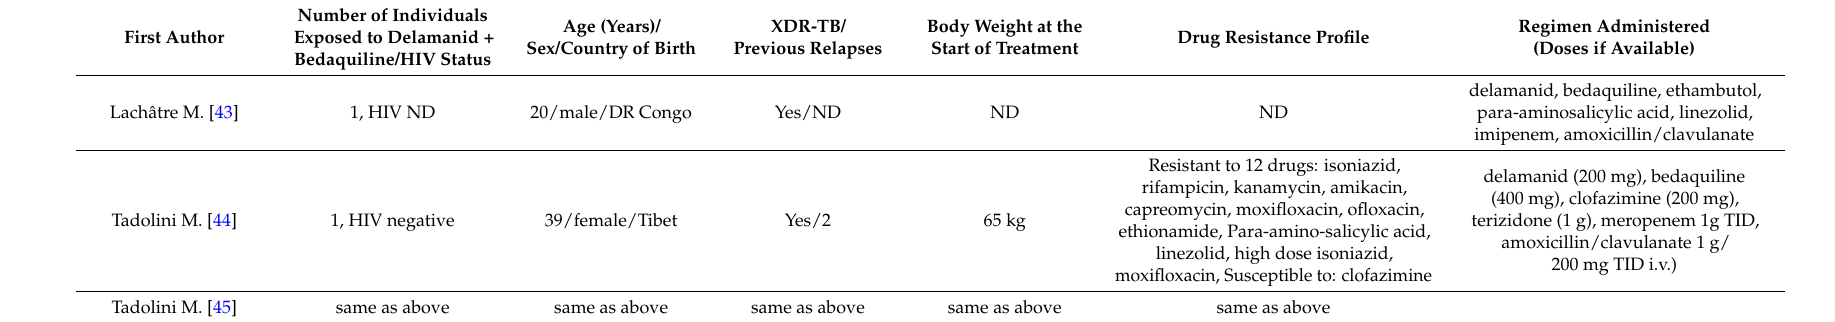
Table 2. Clinical features of the selected studies.